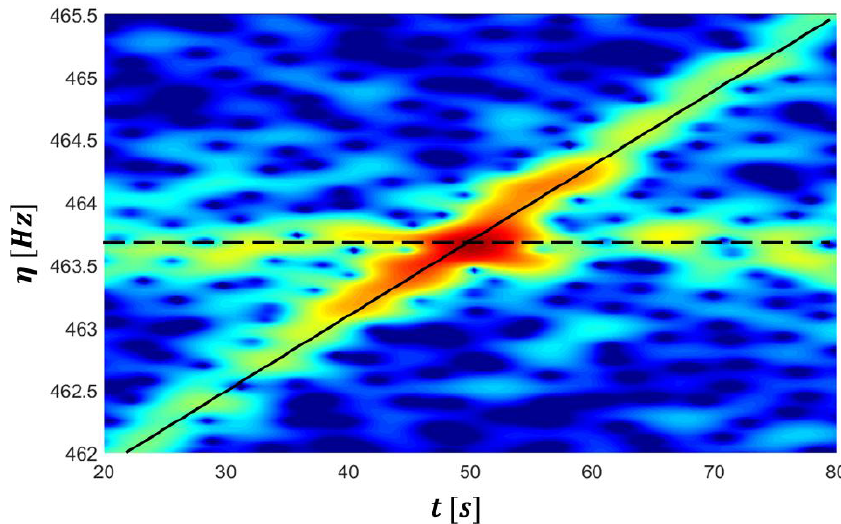
Figure 9. Continuous wavelet transform for first mode shape, ND = 4, backward traveling wave.